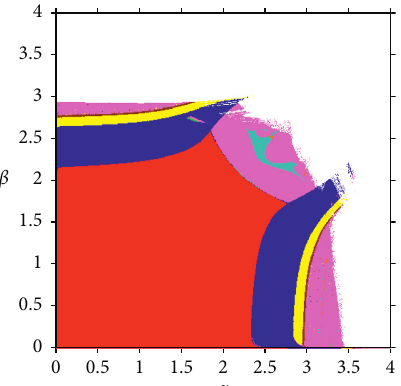
Figure 1: The parameter basins in the ( α , β ) plane with d � 0 .